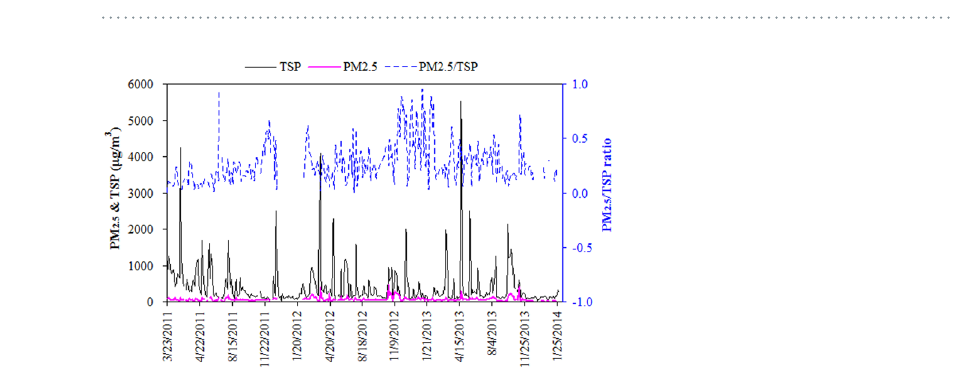
Figure 1. The Hotan observational site set up at the southern Taklimakan Desert is denoted by the black pushpin marker in the enlarged inner figure. Human population density with a spatial resolution of ~1 km 2 based on the 2010 LandScan global population dataset (http://www.ornl.gov/landscan/) is also plotted (The Asia map is from Google Earth Pro 7.3.0.3832 (32-bit), https://www.google.com/earth/download/gep/agree.html and the population map is created by ArcGIS 10.0, https://www.arcgis.com/features/index.html).